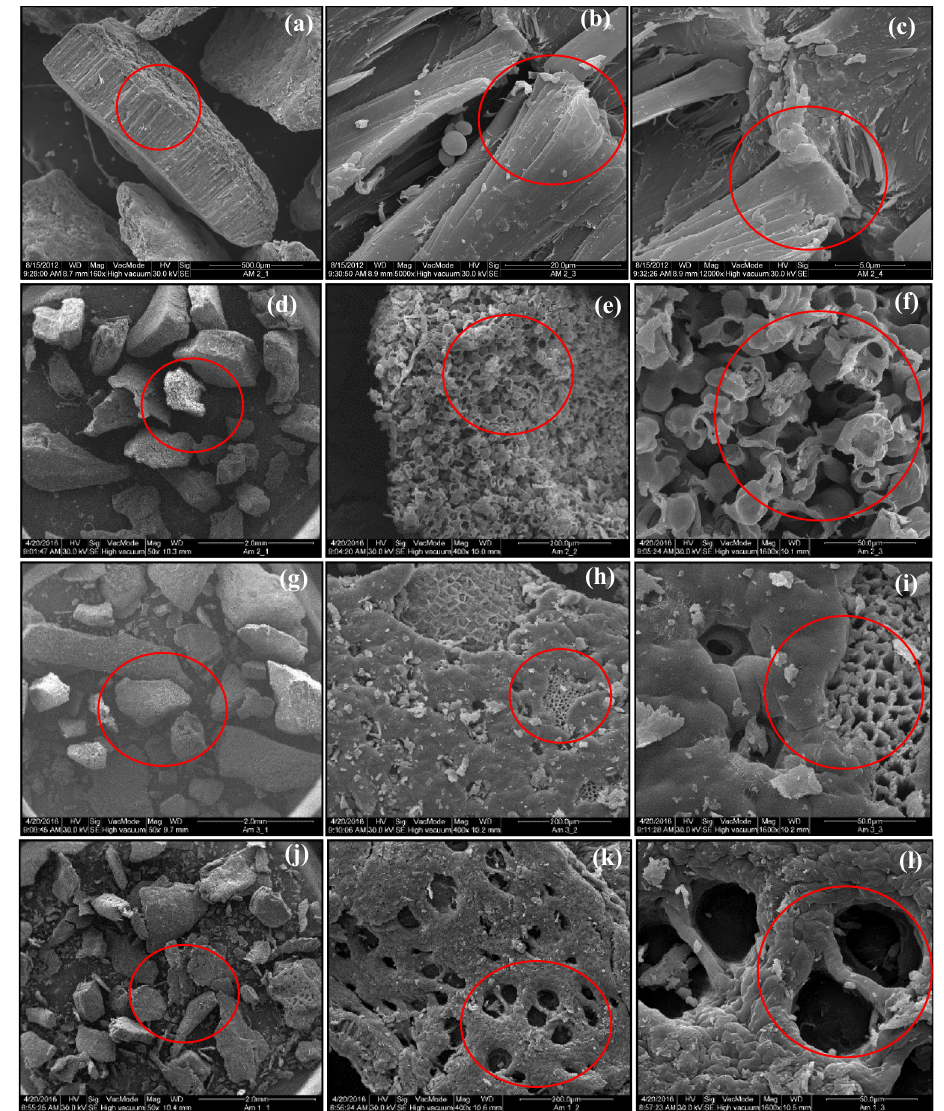
Fig. 1 Scanning electron microscopy to shell of cashew nut (CNS) in natura with magnifications of 160 ( a ), 5000 ( b ) and c 12,000 times ( source : COELHO et al. 2014) and chemically modified with H 2 O 2